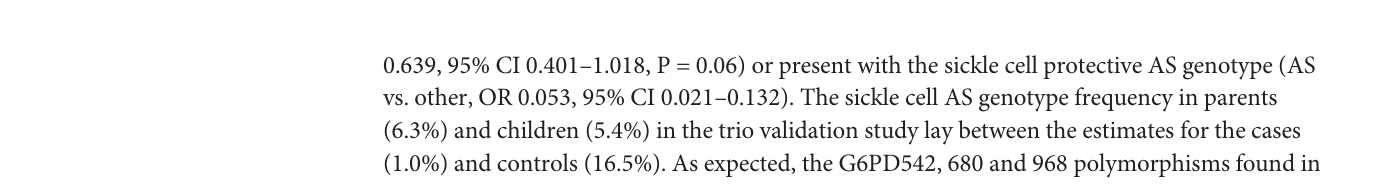
vs. other, OR 0.053, 95% CI 0.021 – 0.132). The sickle cell AS genotype frequency in parents (6.3%) and children (5.4%) in the trio validation study lay between the estimates for the cases (1.0%) and controls (16.5%). As expected, the G6PD542, 680 and 968 polymorphisms found in